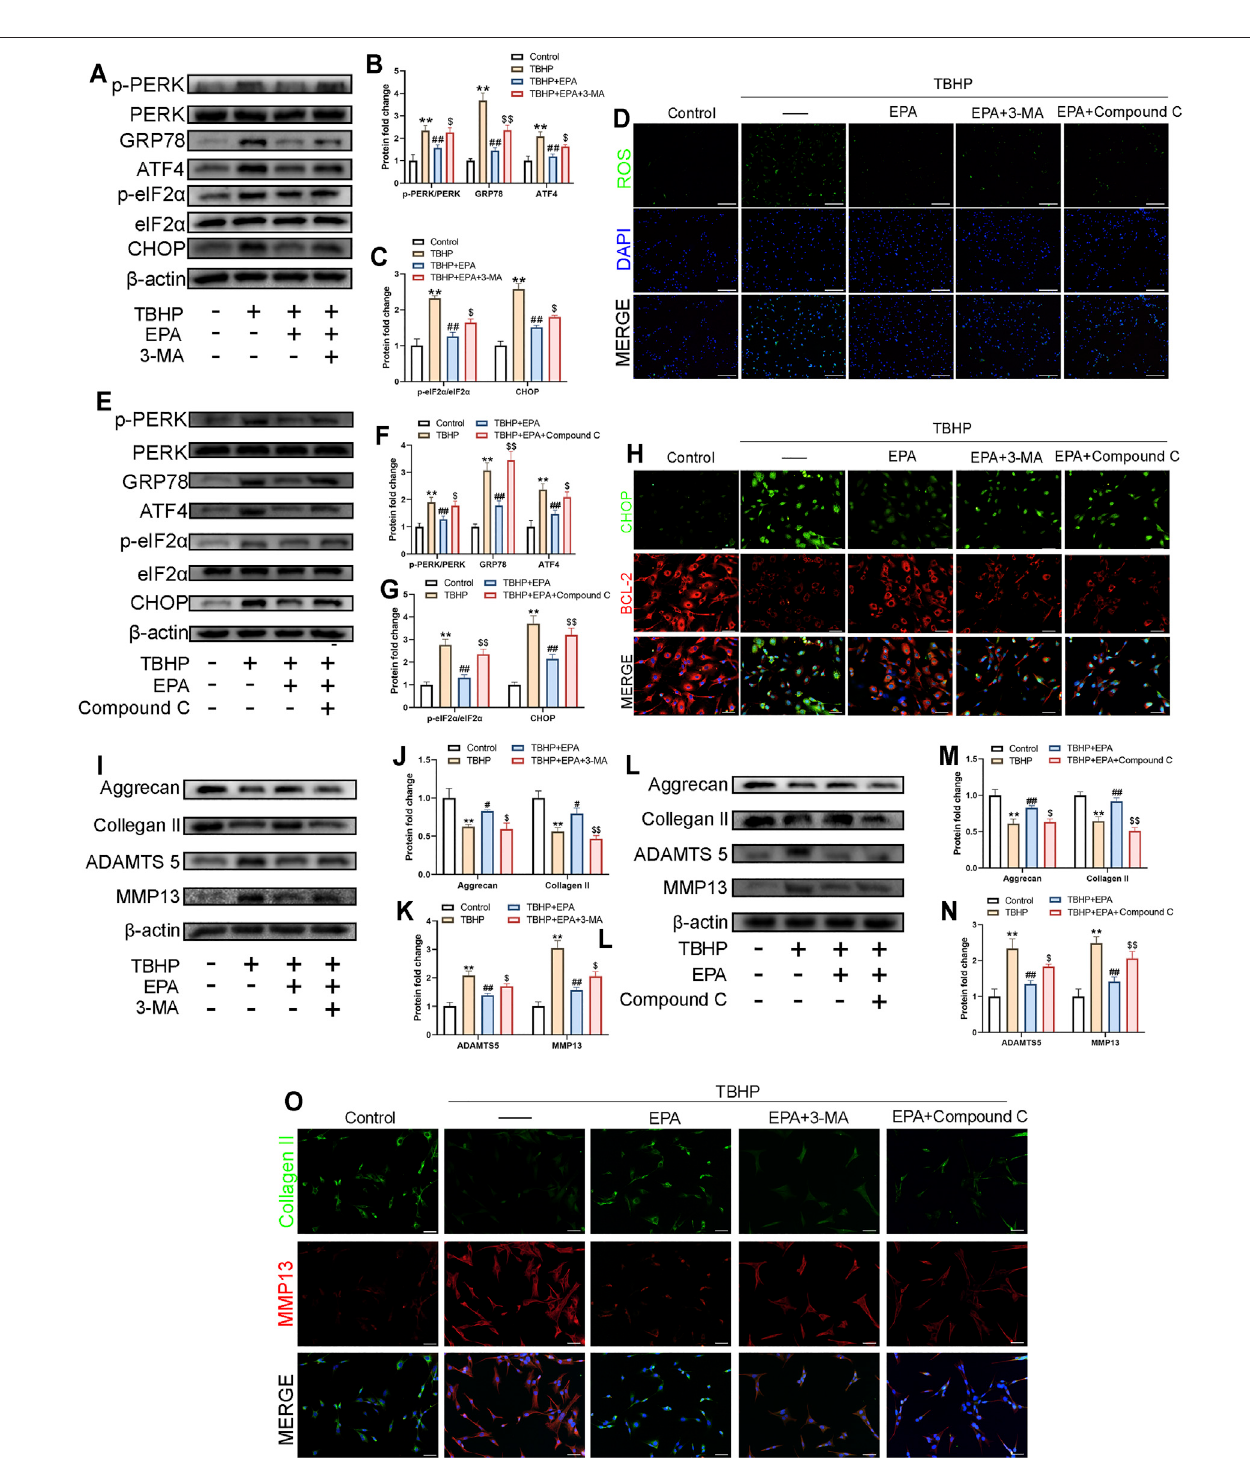
FIGURE 5 | EPAinhibits ER-stress levelsand ECM degradation in NPCs by promoting autophagy. (A – C,E – G) The western blotresultsofp-PERK/PERK, GRP78, ATF4, p-eIF2 α /eIF2 α andCHOPinEPA ’ streatingwith3-MAorCompoundCpretreatmentbeforeTBHPaddition. (D) ReactiveOxygenSpecies(ROS)inNPCswereassessedwithROS Assay Kit (green). Nuclei were counterstained with DAPI (blue) (bar: 100 μ m). (H) The representative images of double immuno fl uorescence staining in NPCs treated as above (green signals represent CHOP, red signals represent BCL-2, scale bar: 20 μ m). (I – N) The western blot results of Aggrecan, Collagen II, MMP13 and ADAMTS5 in EPA ’ s treatingwith3-MAorCompound CpretreatmentbeforeTBHPaddition. (O) Therepresentativeimagesofdoubleimmuno fl uorescencestaininginNPCstreatedasabove(green signalsrepresentCollagenII,redsignalsrepresentMMP13,scalebar:20 μ m).Thevaluespresentedarethemeans ± SD( n (cid:2) 3).* p < 0.05,** p < 0.01,comparedwiththecontrol group; # p < 0.05, ## p < 0.01, compared with the TBHP treatment group; $ p < 0.05, $$ p < 0.01, compared with the TBHP and EPA treatment group.